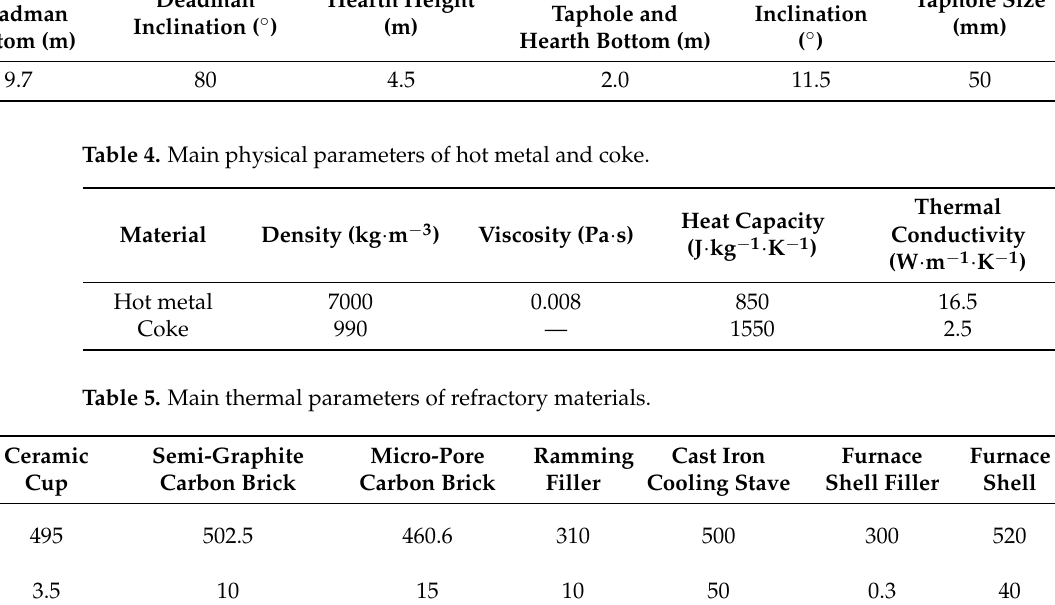
Figure 1. The geometric model of the hearth of the WISCO No. 1 BF. 1 Deadman, 2 Coke-free zone, 3 Ceramic cup, 4 Semi-graphite carbon brick, 5–6 Micropore carbon brick, 7 Semi-graphite carbon Table 3. Main geometrical parameters of the hearth of WISCO No. 1 blast furnace. Table 4. Main physical parameters of hot metal and coke.